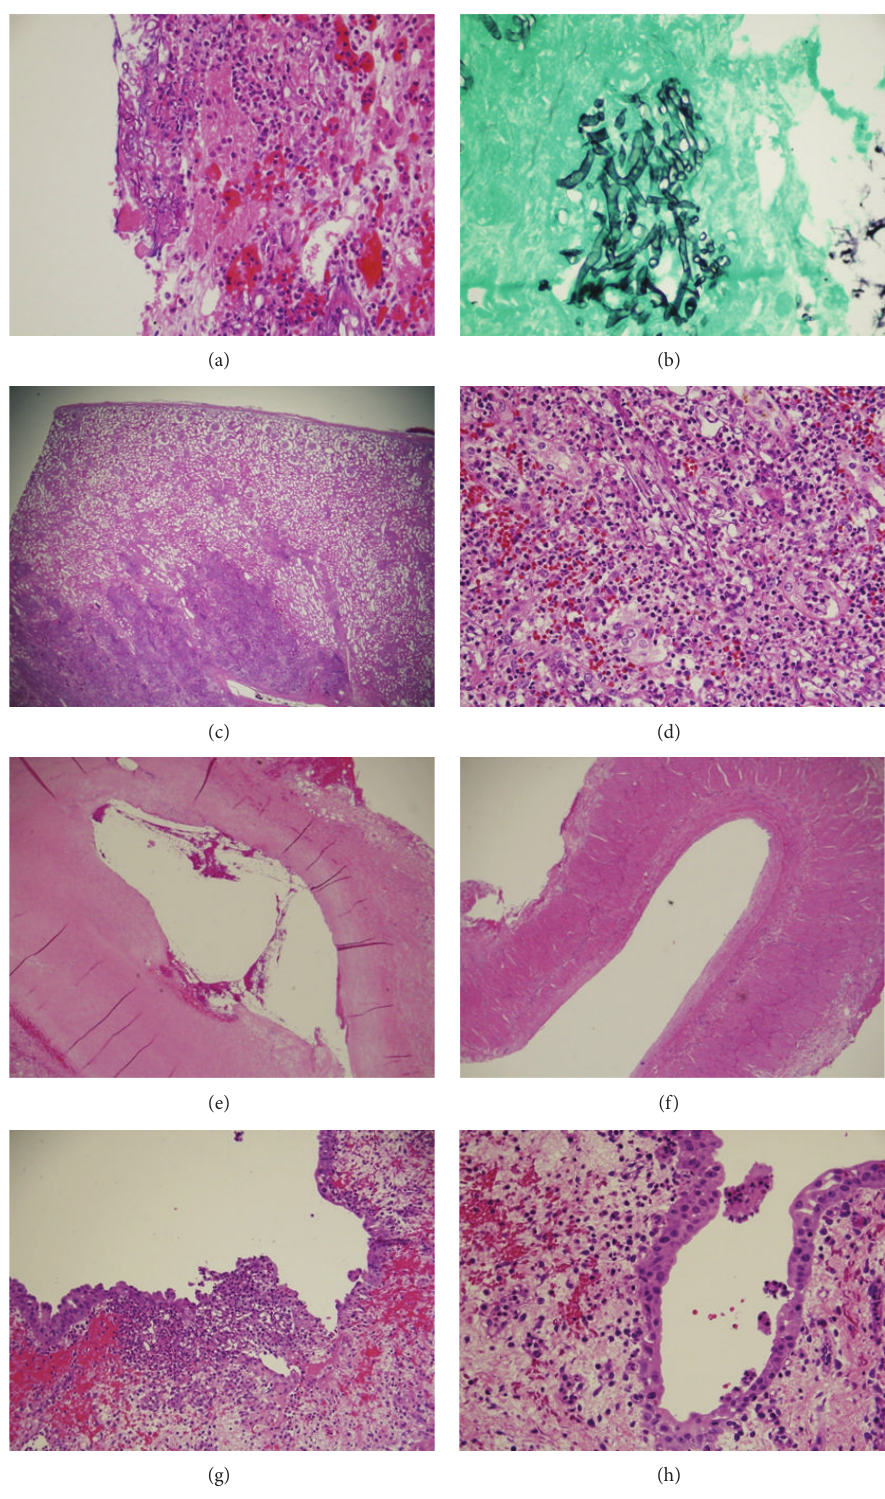
Figure 1: Case A renal allograft histology. Figures 1(a) and 1(b) show renal allograft biopsy indicating broad, pleomorphic, and thin walled fungalsmallfragmentsandhyphaewithrightanglebranchingandmucoidfeatureinpresenceoftissuenecrosisconsistentwithmucormycosis in hematoxylin and eosin stain (a) and Gomori’s methenamine silver stain (b). Explanted allograft kidney demonstrates diffuse and invasive mucormycosis predominantly involving the medulla noted by low magnification in (c) and high magnification in (d) on H&E stain; no mucormycetes invasion of renal artery (e) and vein (f); mucormycetes invasion in proximal portion of ureter indicative of donor ureter (g), and no mucormycetes invasion in distal portion of ureter indicative of recipient ureter